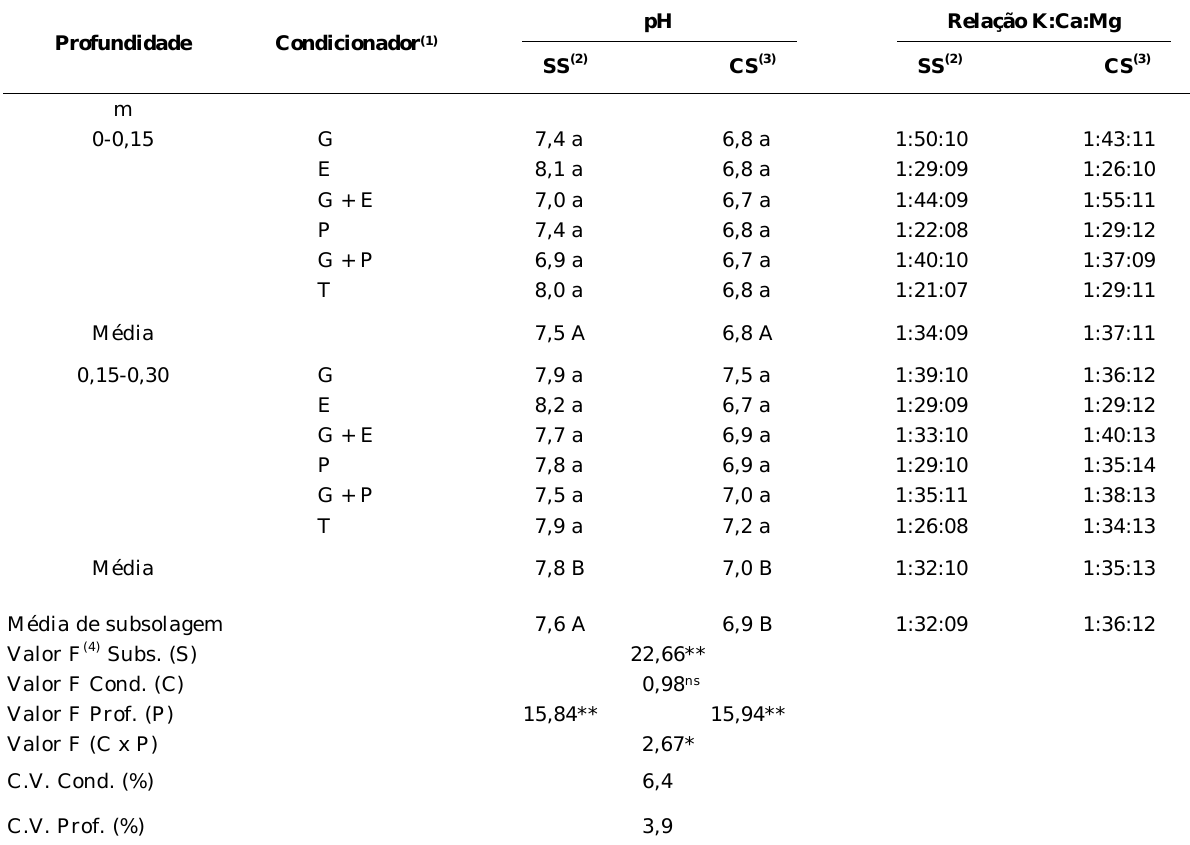
Quadro 2. Valores de pH e relação entre cátions trocáveis nas duas camadas do solo, sob efeito de